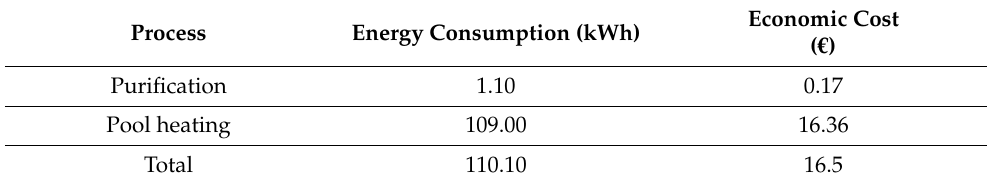
Table 1. Diary energy consumption and economic cost of each process under scenario 1.